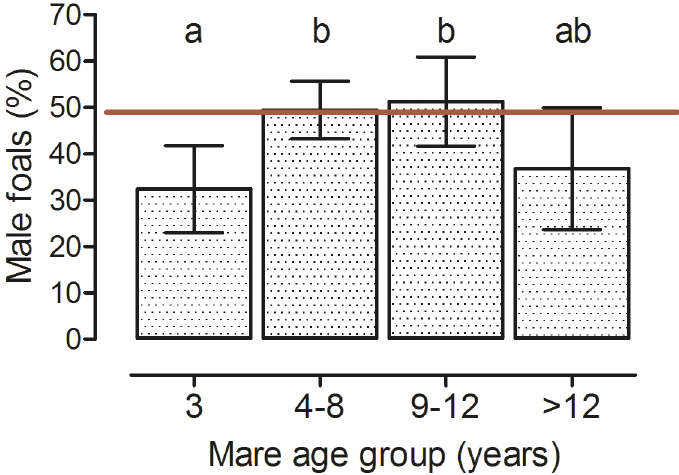
Fig 4. Percentage of male foals among the offspring of mares from different age groups. Mare age at conception has an impact on the proportion of fillies and colts born (Model B, p = 0.003; 3 years: n = 116, 4 – 8 years: n = 338, 9 – 12 years: n = 124, > 12 years: n = 63; LSM ± upper and lower confidence limits; ab: groups with different superscript letters differ significantly, p < 0.05; red horizontal line indicates expected 50% ratio of male foals born).